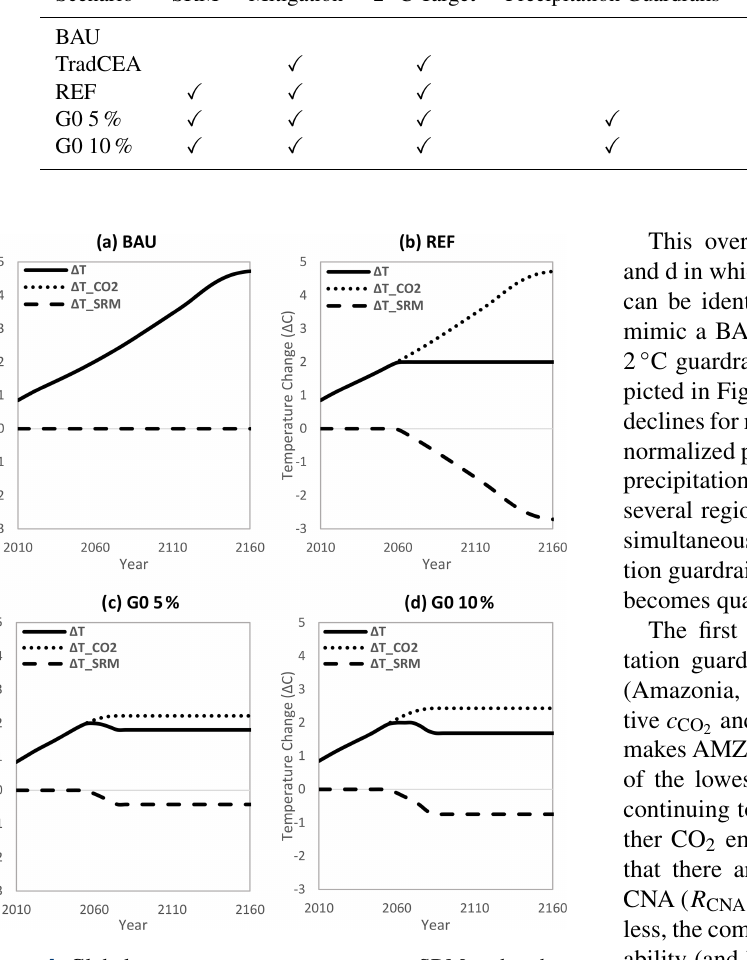
Figure 4. Global mean temperature response to SRM and carbon dioxide forcing. Dotted lines are the resulting effects on global mean temperature for temperature response to CO 2 forcing; the dashed lines are the resulting effects on global mean temperature for temperature response to SRM forcing; the solid lines are the sum of both dotted and dashed lines. (a) No policy (“BAU”); (b) 2 ◦ C tar- get activated and unlimited usage of SRM (“REF”); (c) all Giorgi regions’ precipitation guardrails being activated when the extra ad- missible area is 5% of the standard deviation (“G0 5%”); (d) simi- lar to panel (c) but with 10% of the standard deviation (“G0